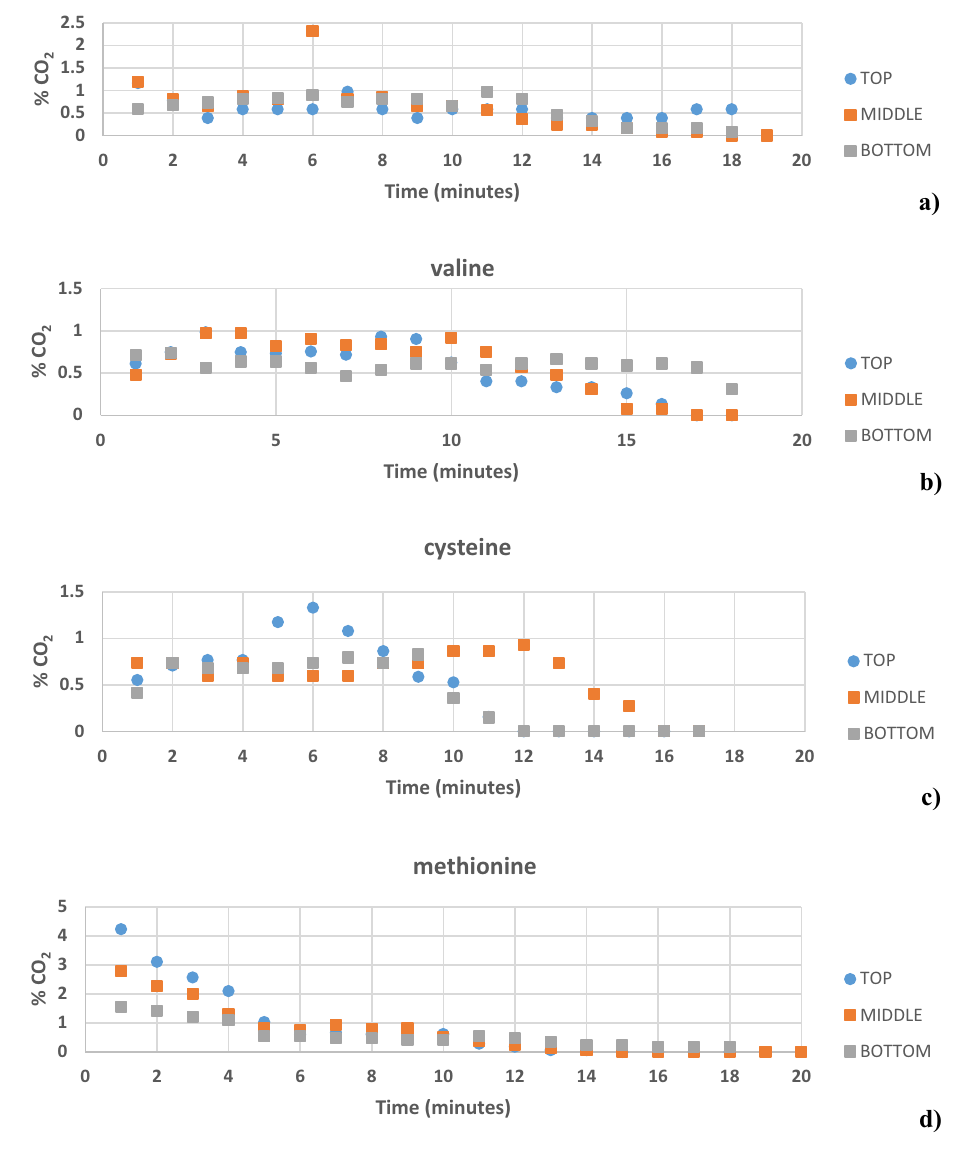
Figure 4. The % CO 2 present in different zones of GH block with ( a ) leucine, ( b ) valine, ( c ) cysteine, and ( d ) methionine as